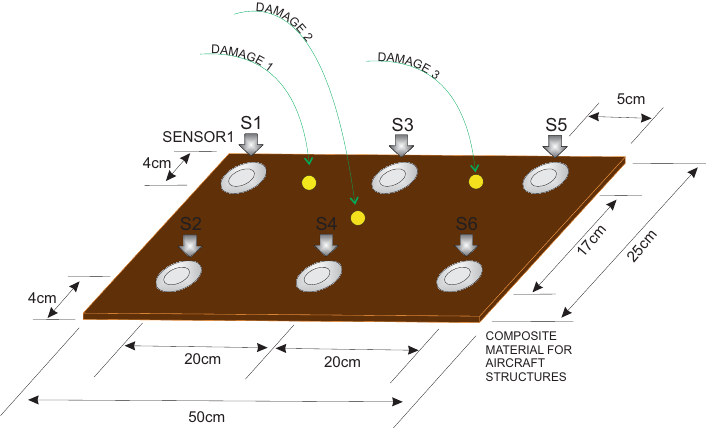
Figure 18. Experimental setup for the composite